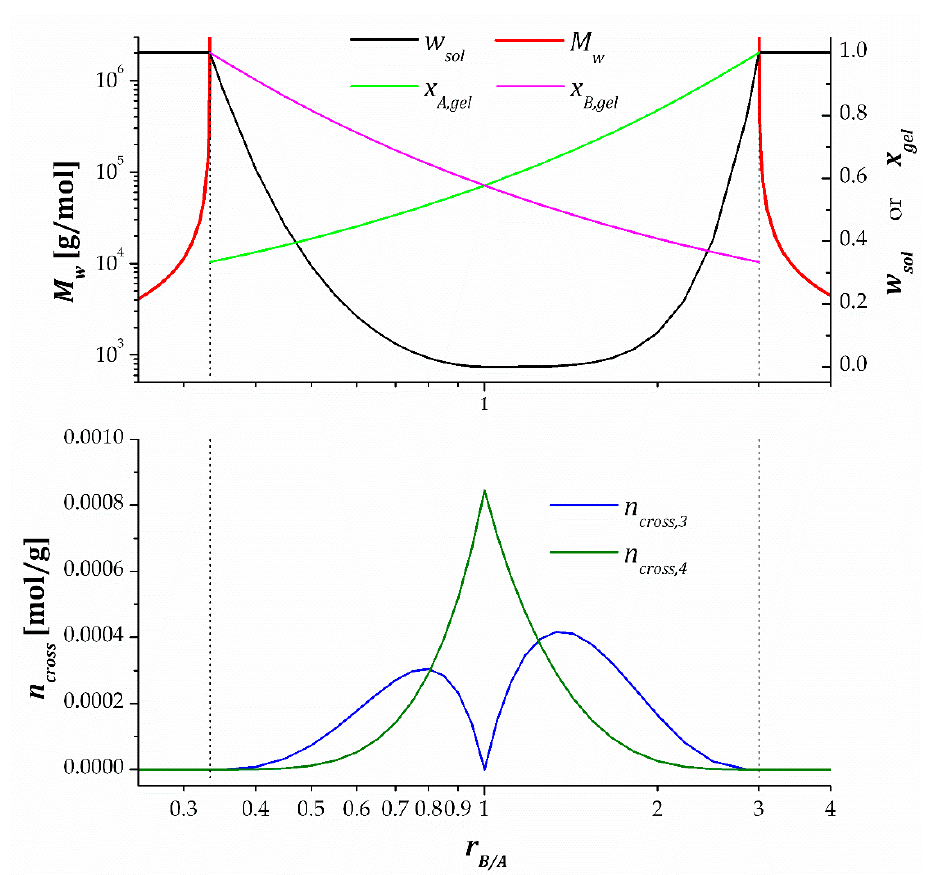
Figure 3. Evolution of feed ratio of functionalities A and B , r B / A , on build-up statistical averages for an ideal A 2 − B 4 stepwise copolymerization. The dashed vertical lines on both graphs represent the critical ratios r B / A , crit = 1/3 and r B / A , crit (cid:48) =